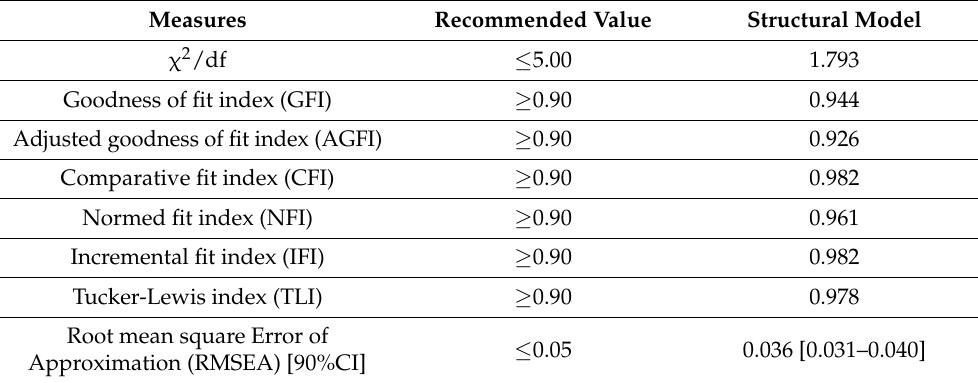
Table 6. Evaluation of model goodness-of-fit—Users.